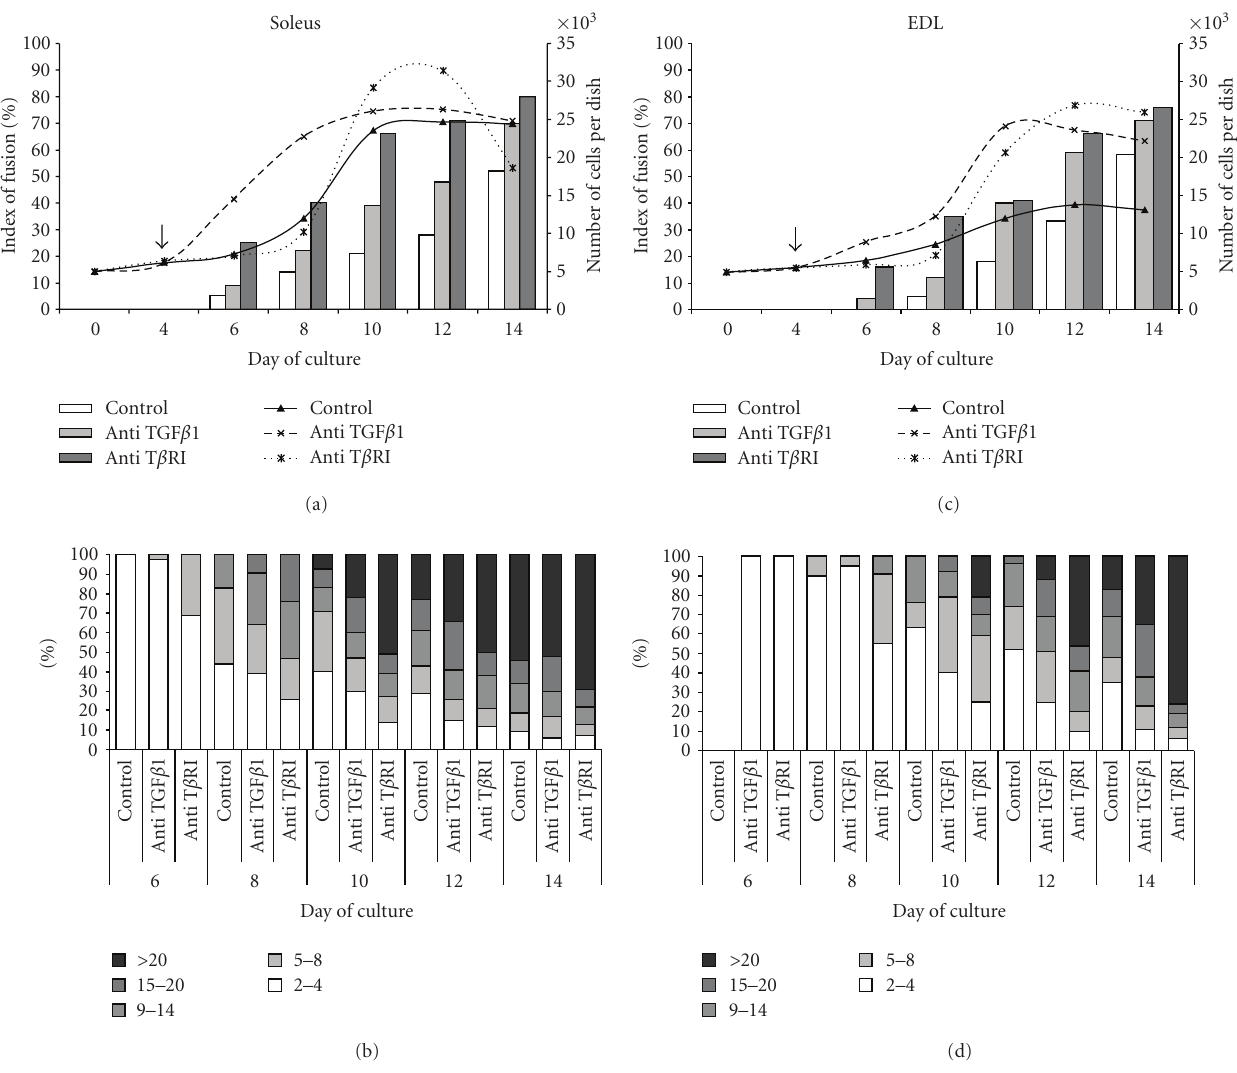
Figure 6: Growth and di ff erentiation of soleus and EDL derived myoblasts . E ff ects of anti-TGF β 1 and anti-T β RI antibody treatments . Untreated myoblasts (control) and myoblasts treated at day 4 after plating (arrow) with either anti-TGF β 1 or anti-T β RI antibody were cultured as described above. In the cultures of (a) soleus and (c) EDL derived myoblasts, cellular growth (shown as curves) was measured by counting the cells after trypsin dissociation. Index of fusion (shown as bars) was expressed as the percentage of nuclei found in myotubes compared to the total number of nuclei. Distributions of myotubes (as % of total myotubes) found in (b) soleus and (d) EDL derived myoblast cultures according to their size, depending on the number of nuclei they contained. Counting was performed at the indicated days after plating on cultures stained with May-Gr¨unwald-Giemsa. Values are mean ± SE of three independent